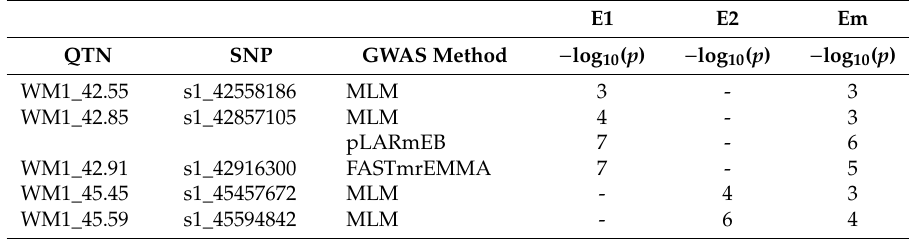
Table 2. Significant white mold (WM)-SNP associations identified using one single locus-genome-wide association study (SL-GWAS) method (mixed linear model—MLM), 6 ML-GWAS methods